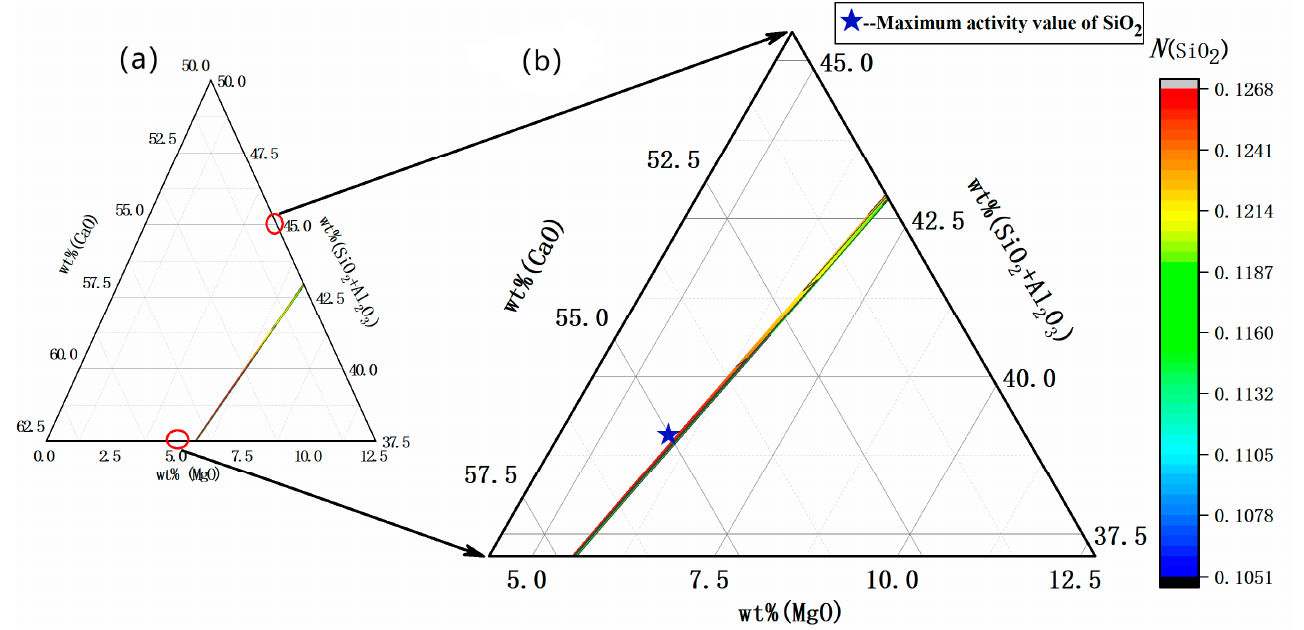
Figure 3. ( a ) Slag composition of the CaO-(SiO 2 + Al 2 O 3 )-MgO pseudo-ternary system. ( b ) Model predicted values: effect of CaO content on SiO 2 activity in refining slag.